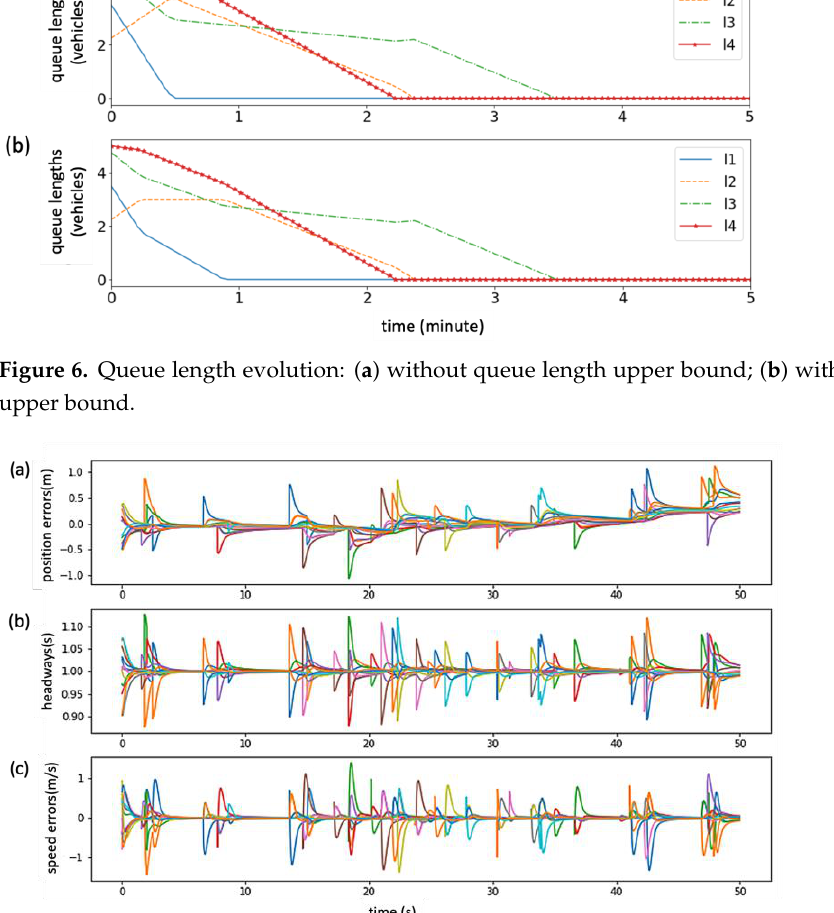
Figure 7. Stability and safety analysis of virtual platoon control: ( a ) position errors; ( b ) headways; ( c ) speed errors.